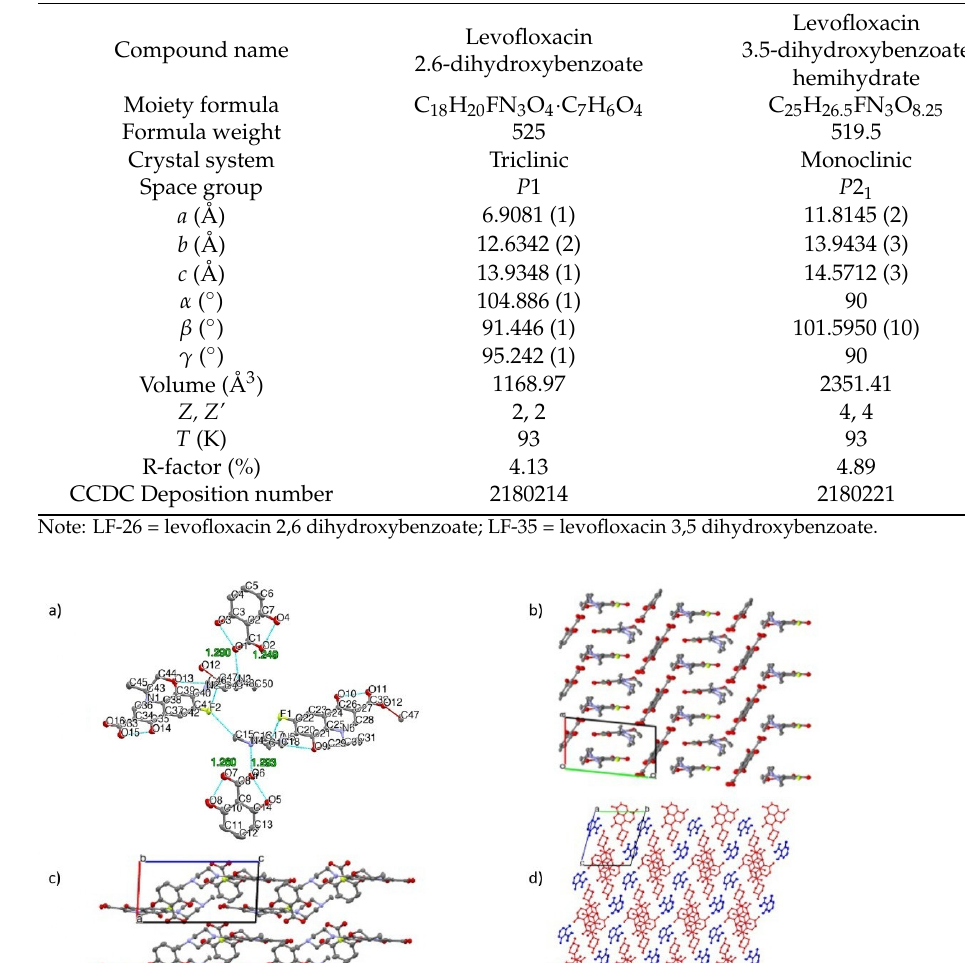
Figure 9. ( a ) Thermal ellipsoid drawing with atomic labeling scheme of LF-35 at 50% probability level. The dashed blue lines indicate intramolecular hydrogen bonds, while the dashed cyan lines indicate intermolecular hydrogen bonds. ( b ) Packing motifs of LF-35 along the a -axis, hydrogen atoms are omitted for clarity. ( c ) Packing motifs of LF-35 along the b -axis and ( d ) a -axis with sym- metry coloring. The red color indicates LF molecules, while the magenta and green color indicate 3,5-DHBA molecules.